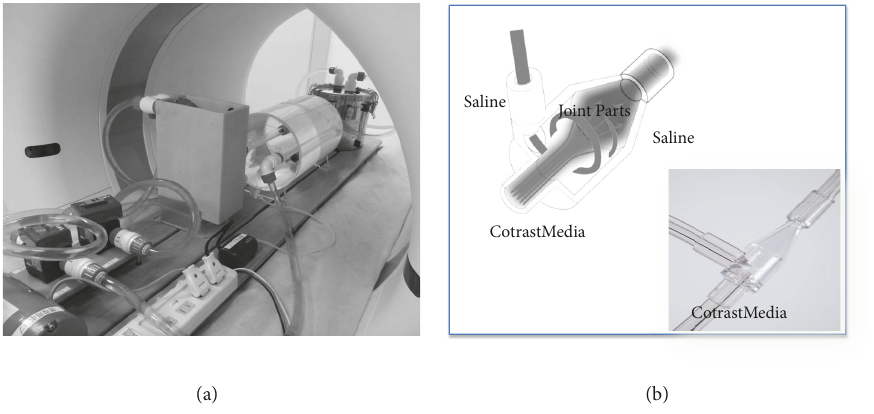
Figure 1: Verification system. (a) Human blood flow phantom and X-ray CT; (b) spiral flow